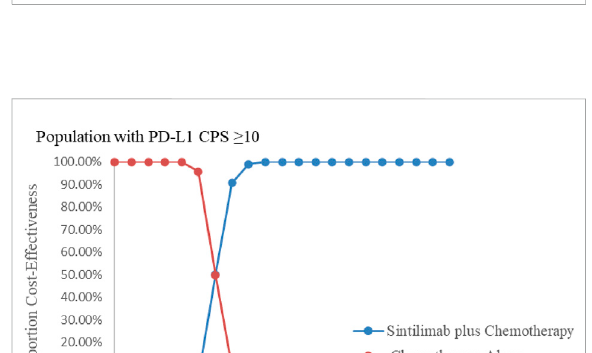
FIGURE 8 Cost-effectiveness acceptability curves in overall population (CEAC).